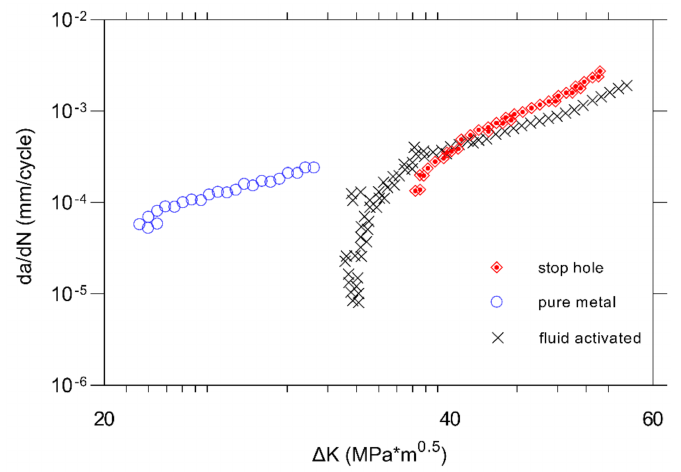
Figure 8. Comparison of fatigue crack growth rates for pure metallic specimens (stop hole, CT specimen with injected fluid).